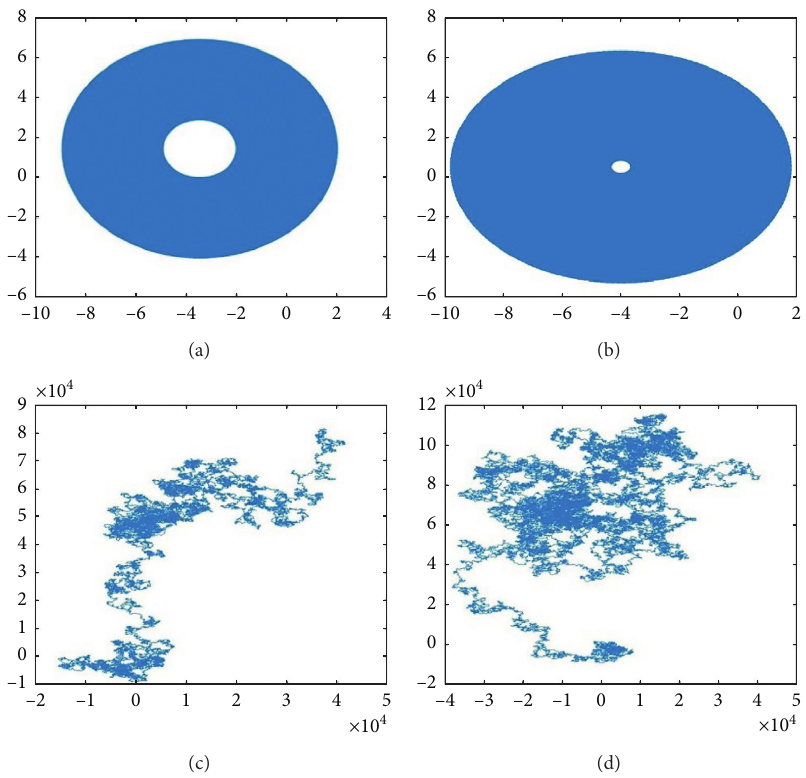
Figure 4: The result of the 0-1 test: (a) L � 0.05 and K � 0.01; (b) L � K � 0.63; (c) L � K � 4; (d) L � K � 10.